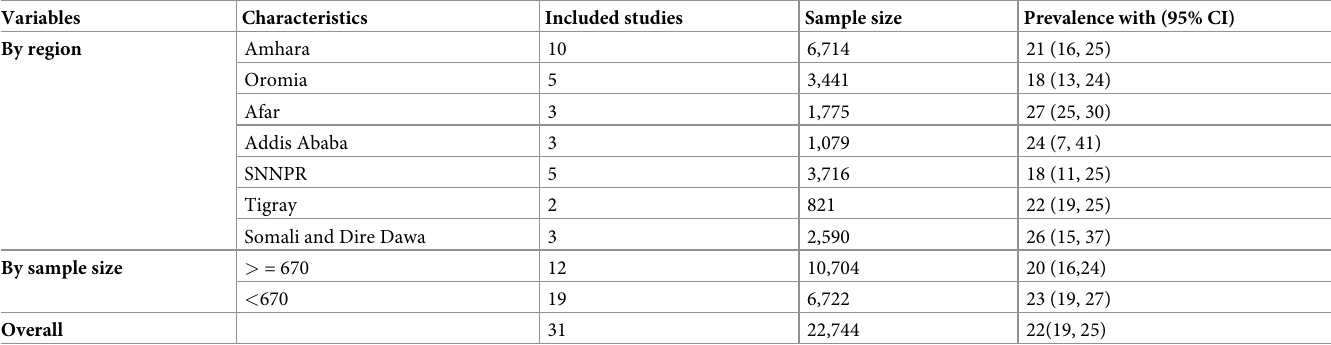
Table 4. Subgroup prevalence of diarrhea among under-five children in Ethiopia, 2017 (n = 31).